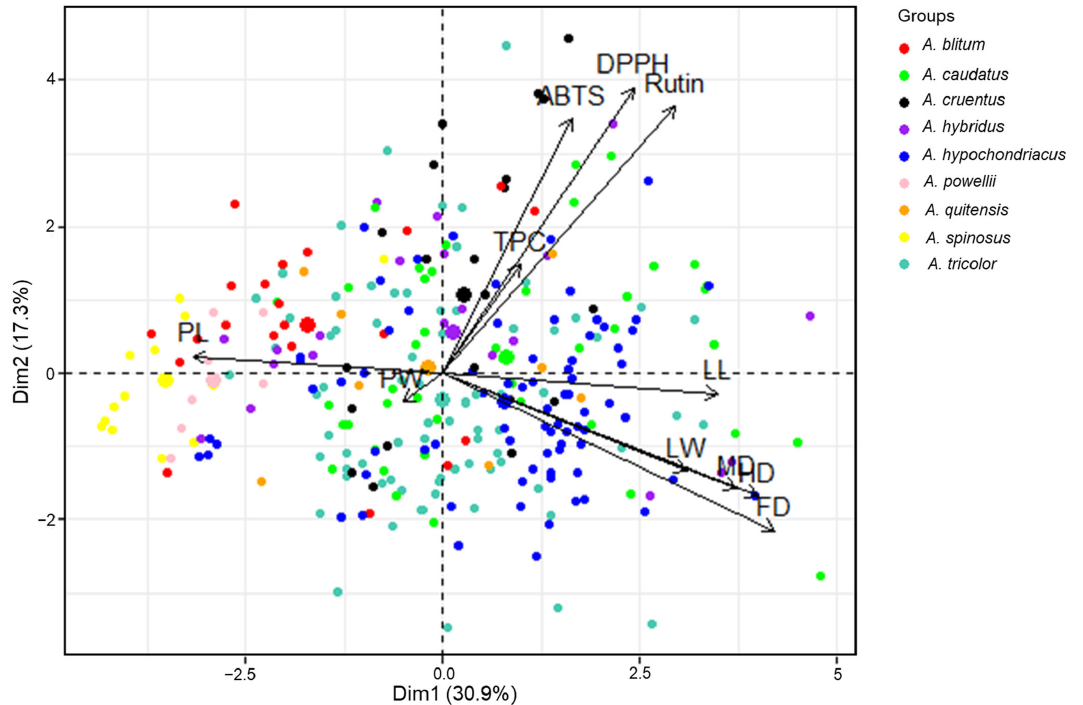
Figure 3. Principal component biplot for Amaranthus species based on their agricultural traits, phytochemical content, and antioxidant activities using the entire dataset. TPC = total phenolic content, DPPH = DPPH radical scavenging activity, ABTS = ABTS radical scavenging activity, LL = leaf length, LW = leaf width, PL = panicle length, PW = panicle width, FD = days until 50% flowering, HD = days until 50% heading, MD = days until maturity.